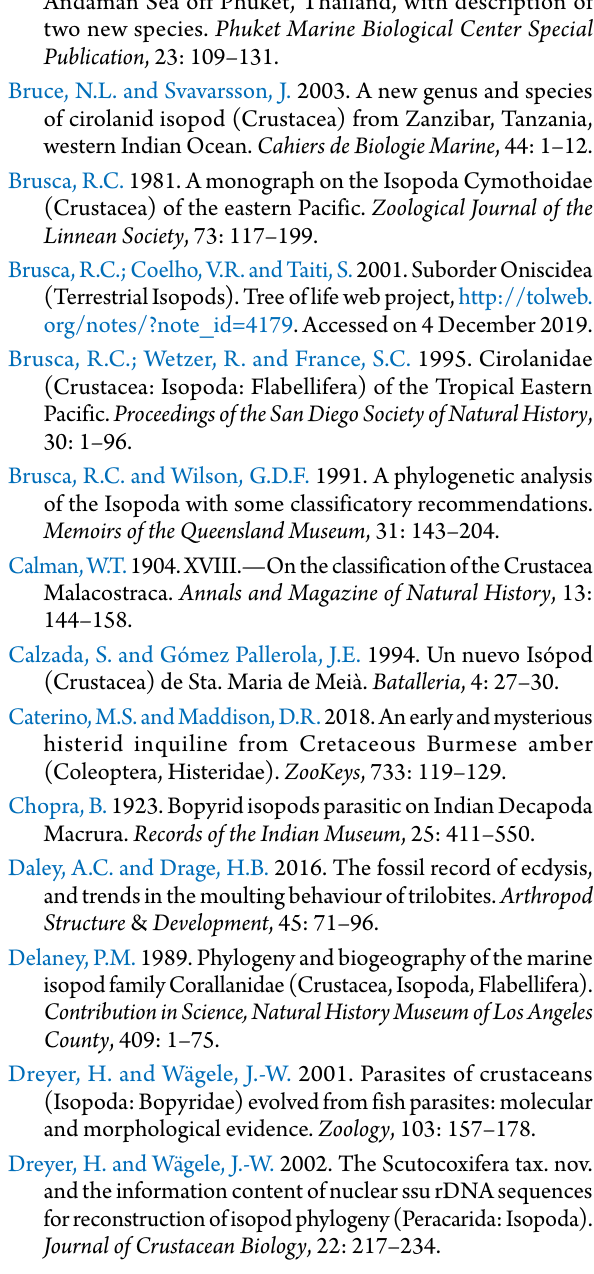
Supplementary file 9: Figure S7. Paratype of Electrolana madelineae sp. nov. (NHMW